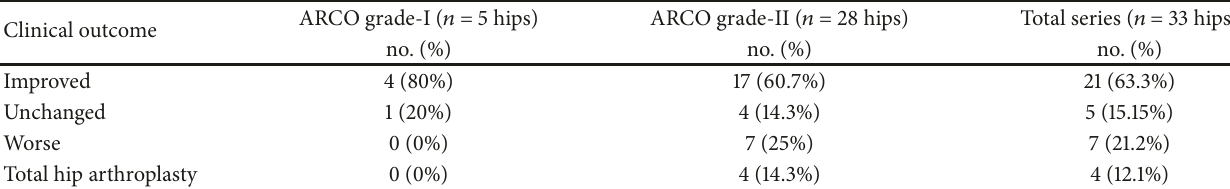
Table 3: The overall clinical outcomes after ESWT.